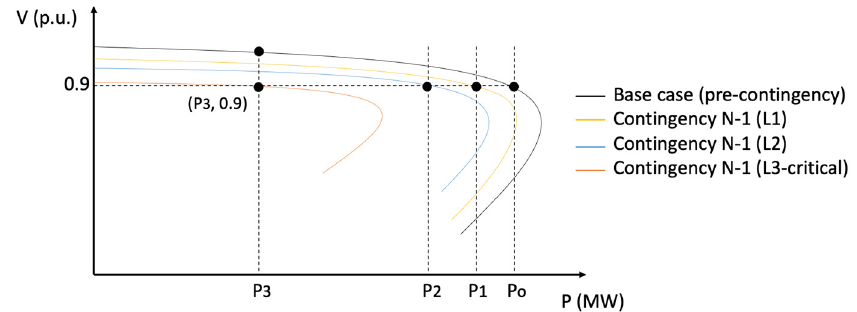
Figure 6. Determination of demand scenarios for the voltage limit (0.9 p.u.).